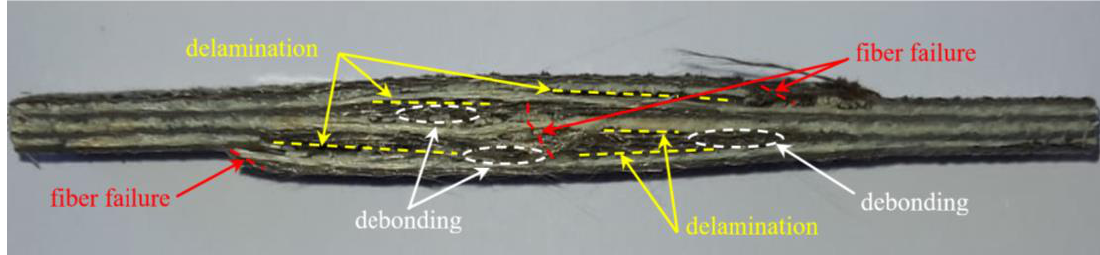
Figure 13. Typical B-SFRP specimen failure after tensile test.